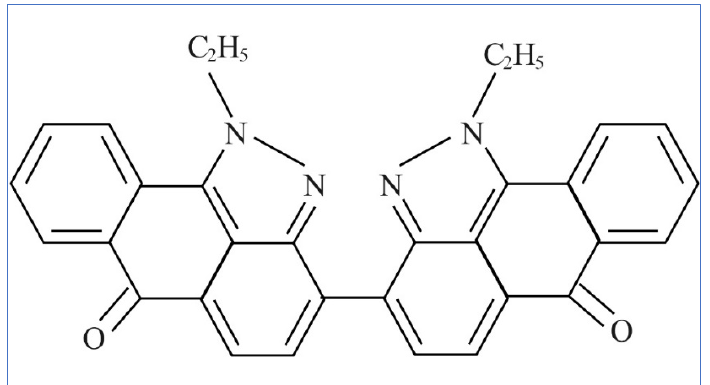
Figure 6. Structure of the vat red 13 dye.